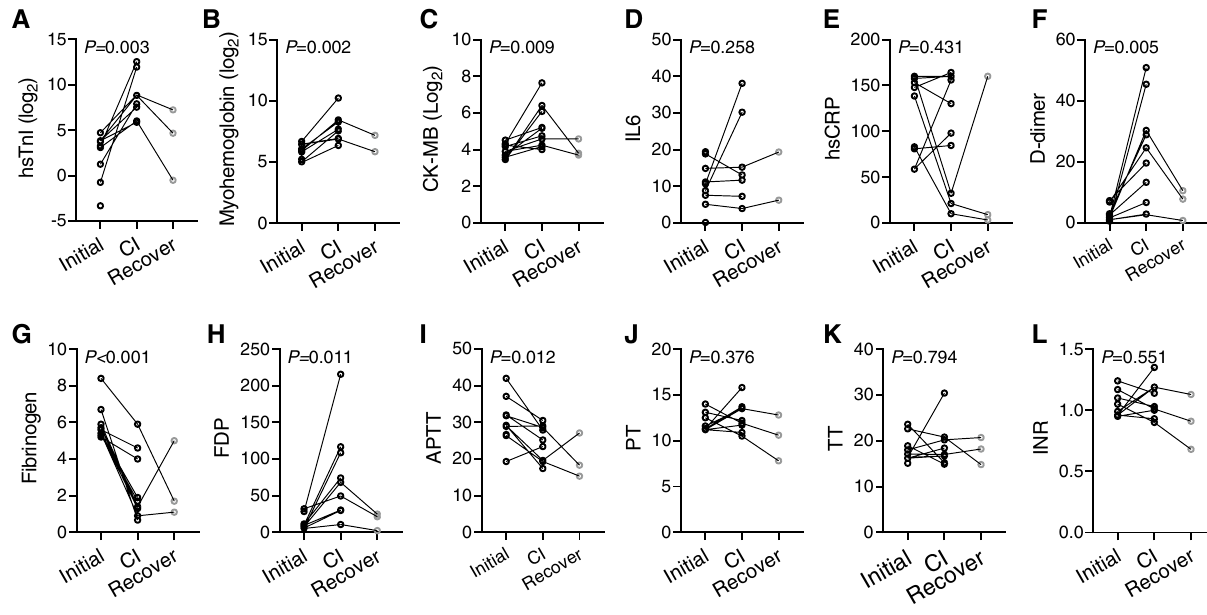
Figure 5. Dynamic changes of cardiac, inflammatory and coagulation biomarkers. The laboratory testing results were obtained from initial time on admission, to cardiac injury (CI) state manifested by elevation of cardiac biomarkers. The recovery state from three patients were also included. P value represented comparison of initial and cardiac injury state, by paired Student’s t -test. FDP, fibrinogen degradation products; aPTT, activated partial thromboplastin time; PT, Prothrombin time; TT, thrombin time; INR, international normalized ratio.